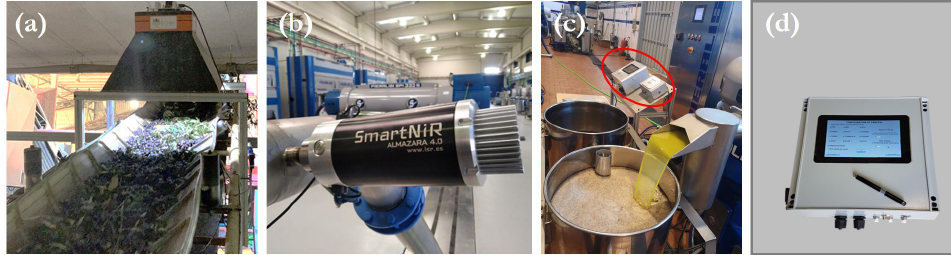
Figure 3. Example of sensory technologies: ( a ) Image acquisition set-up installed at the reception yard; ( b ) NIR device installed after the separation stage; ( c ) Electronic nose installed after the centrifugation stage; and ( d ) HMI to gather operator impressions.